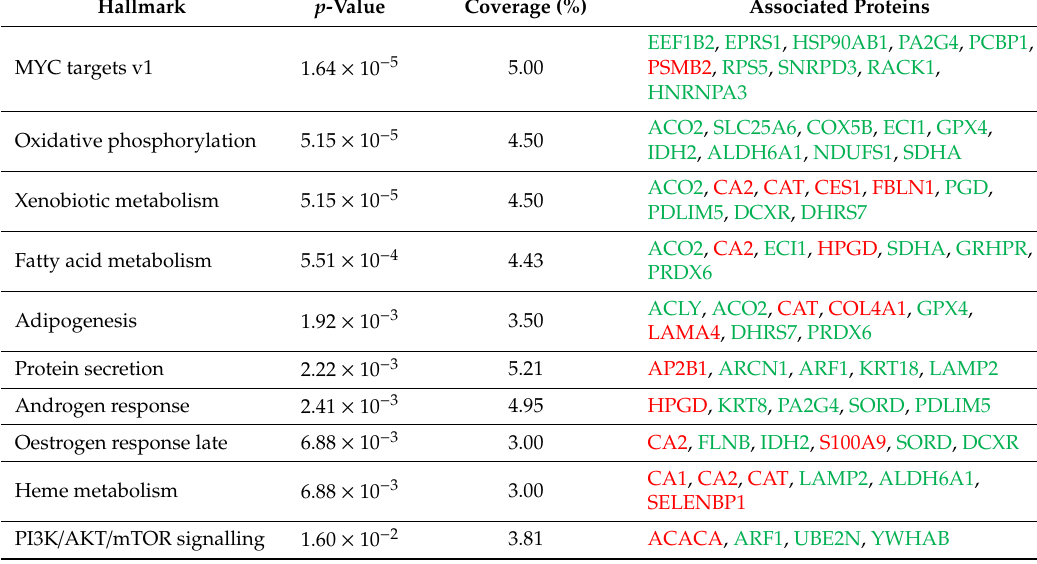
Table 2. Shortlisted biological hallmarks that were found to be significantly enriched against Molecular Signatures Database (MSigDB) hallmark gene